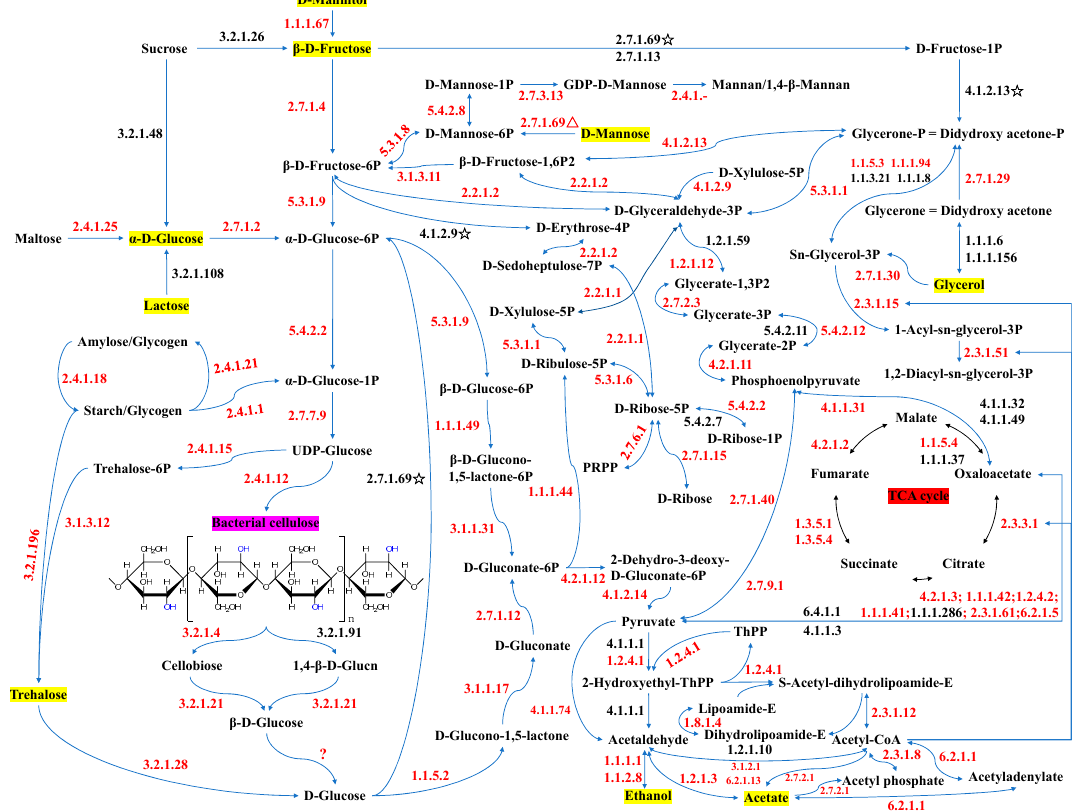
Figure 6. Schematic diagram of carbon metabolism and BC biosynthesis pathways in Komagataeibacter sp. W1. The comprehensive analysis was conducted by incorporating the key metabolic intermediates and associated enzymes responsible for carbon source transformation and BC biosynthesis in different KEGG pathways. The numbers in the figure are the Enzyme Commission number, while the red and black ones indicate the associated enzymes present and absent respectively in Komagataeibacter sp. W1. The asterisks indicate the enzymes absent in the labeled pathways but present in other pathways in our study, thus it is unknown whether they work in the labeled pathways. The question mark indicating whether the pathway is present, is unclear based on our data and remains for future investigations. More information of the enzymes and the associated genes and pathways (ko numbers) are listed in Table S2. P, phosphate; GDP, guanosine diphosphate; UDP, uridine diphosphate; PRPP, phosphoribosyl pyrophosphate; ThPP, thiamine diphosphate; TCA, tricarboxylic acid cycle; Acetyl-CoA, acetyl coenzyme A.